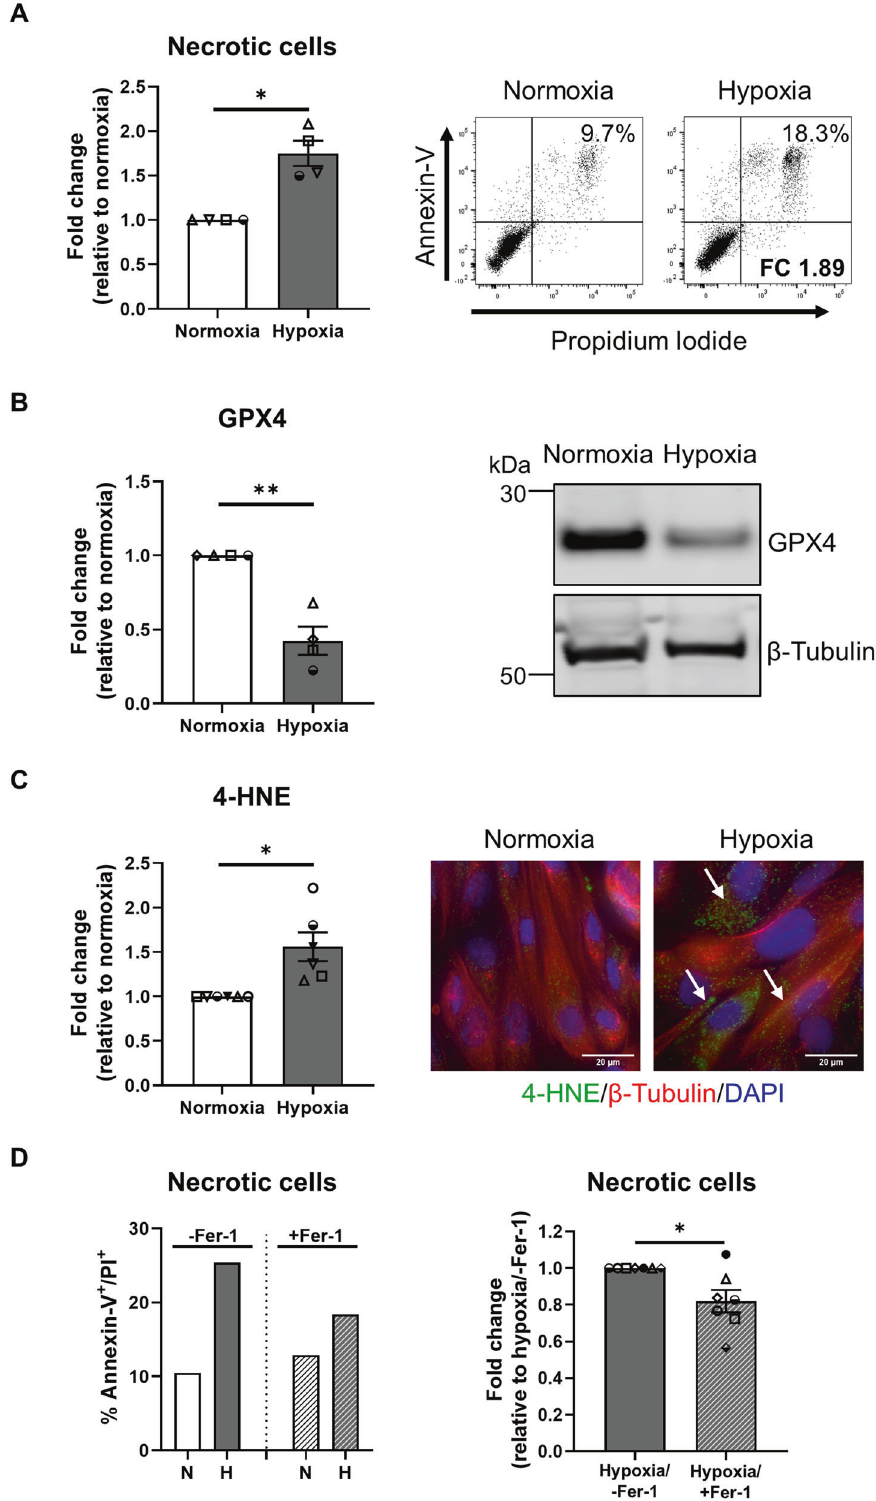
fi brotic kidney tissue (Fig. 3D). Notably, these CD1c + DC were both localised to sites of tubulointerstitial injury and adjacent to ferroptotic PTEC (Fig. 3D). These collective fi ndings provide evidence of spatial co-localisation of ferroptotic PTEC with CD1c + DC in tubulointerstitial fi brosis.